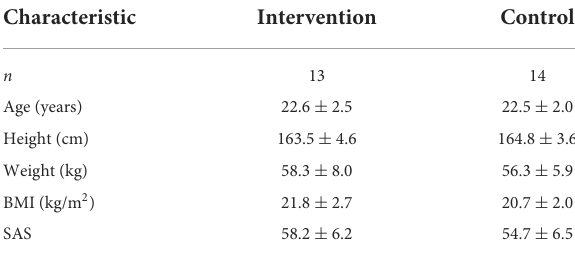
TABLE 1 Baseline characteristics of participants in intervention and control